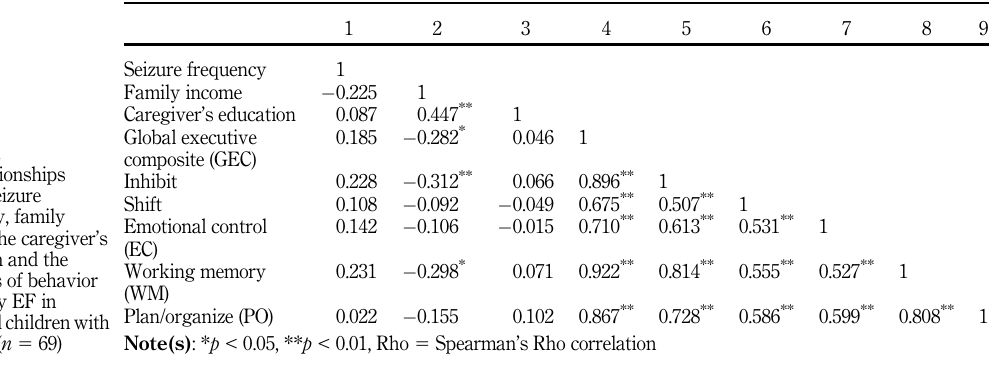
among seizure frequency, family income, the caregiver ’ s education and the subscales of behavior control by EF in preschoolchildrenwith epilepsy ( n 5